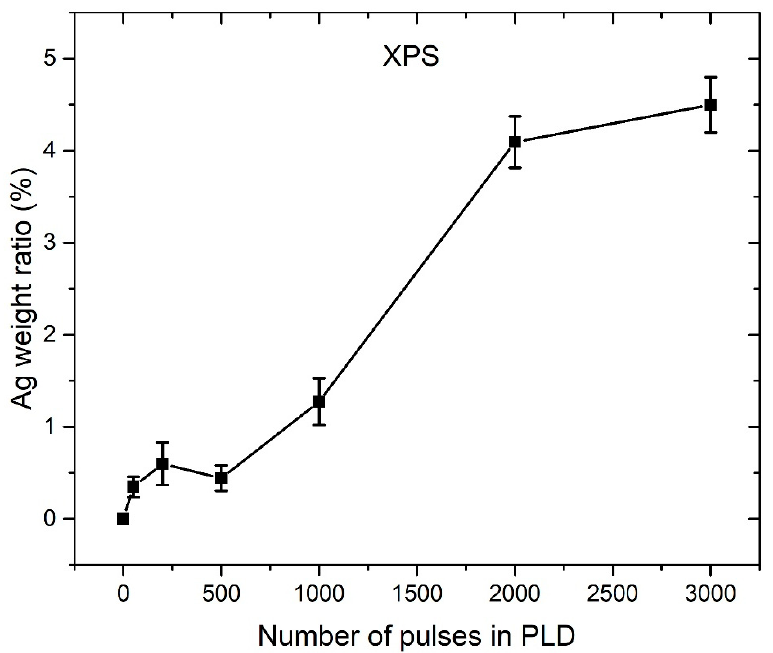
Figure 8. XPS calculated Ag weight ratio in PLAL-synthesized Ag-doped ZnO NP, which is dependent on number of pulses used for Ag deposition in PLD synthesis of PLAL target .